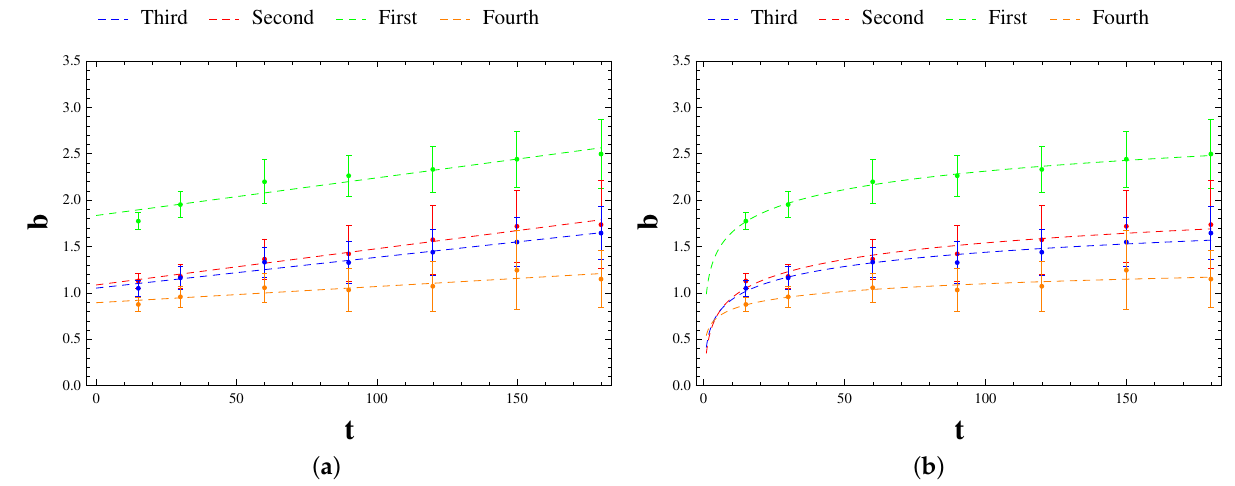
Figure 11. Laws of variation of scaling exponent over the aggregation time: linear law ( a ) and logarithmic law ( b